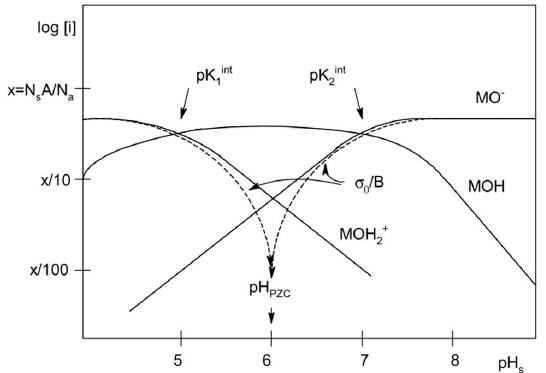
Figure 2. Variation of the surface hydroxyl species concentration with with the surface pH.